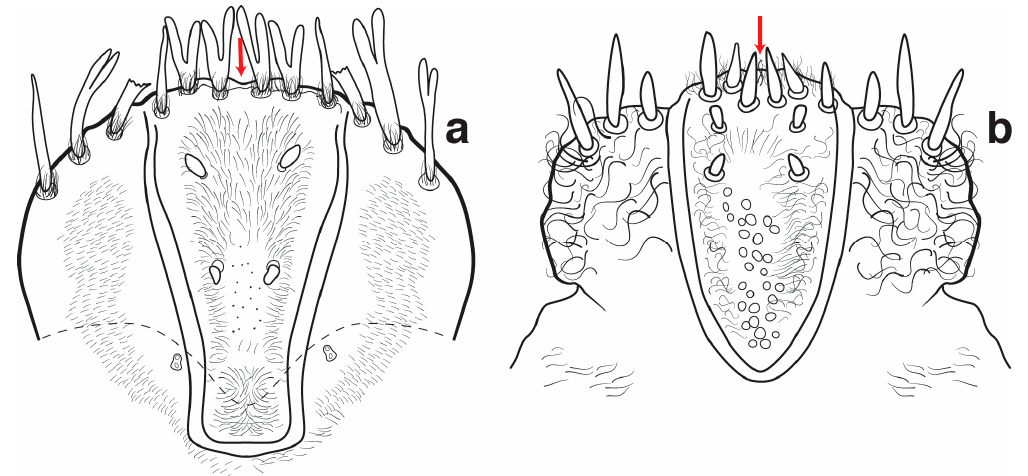
Figure 31. Epipharynx, larva: ( a ) Sphenophorus pontederiae ; and ( b ) Nephius (=Anius) . 18. Short setae at the base of ams1, ams2, and mes3 (Figure 32) a. Absent a.